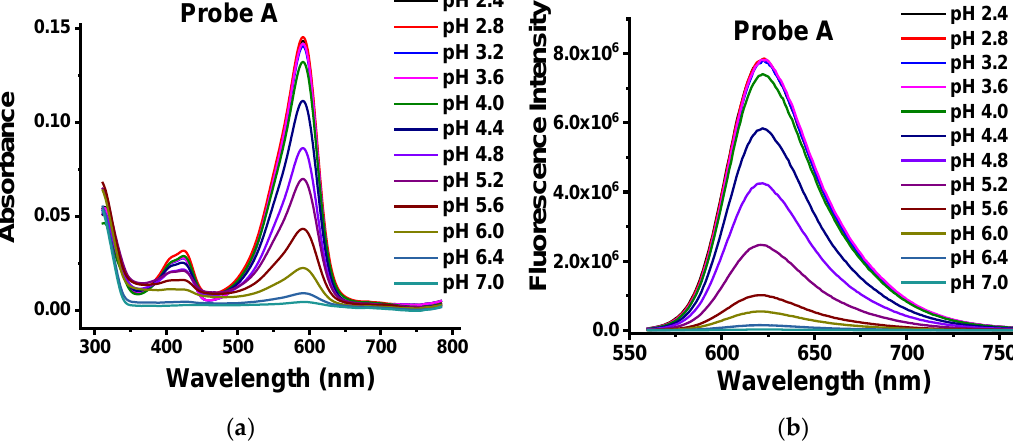
Figure 1. Absorption ( a ) and fluorescence spectra ( b ) of probe A in different pH buffers under excitation at 550 nm.